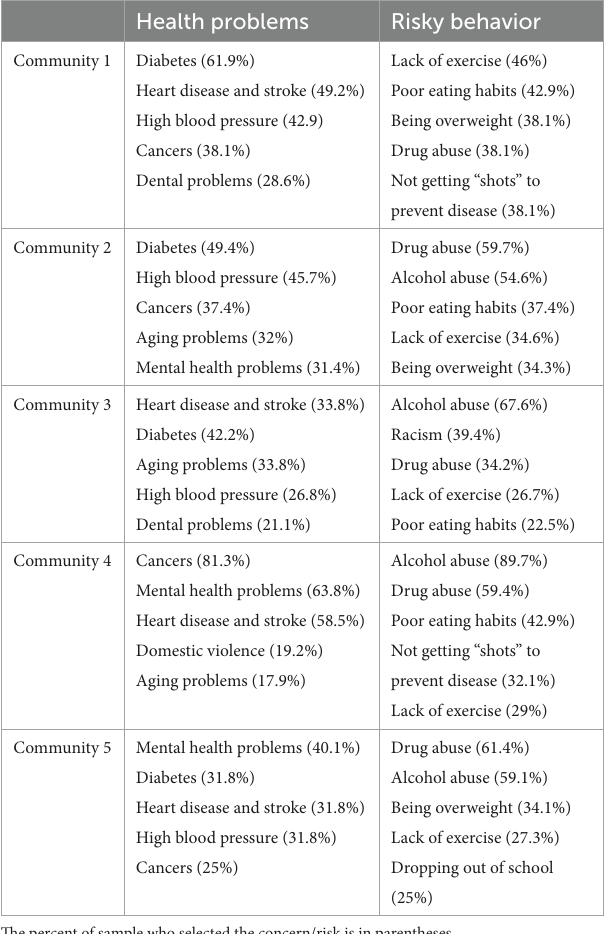
TABLE 3 Most endorsed items by community. Health problems Risky